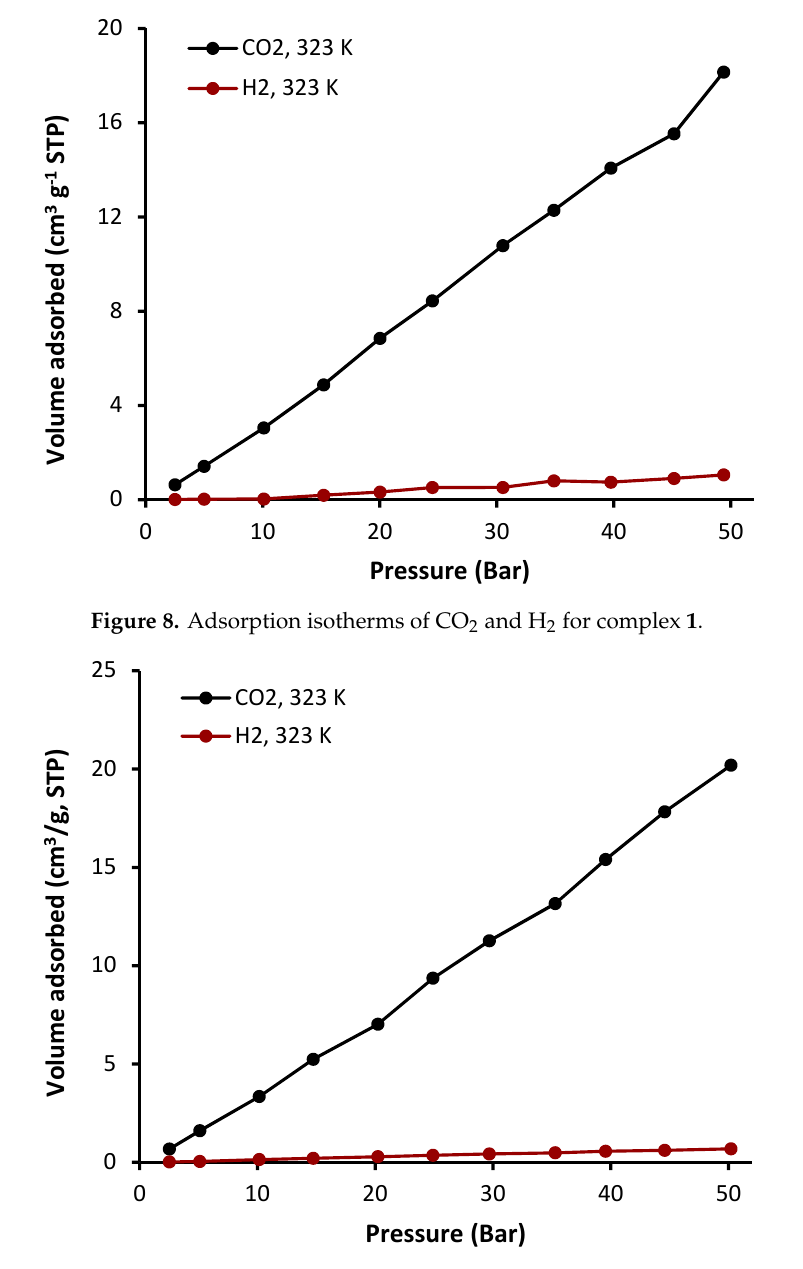
Figure 10. Adsorption isotherms of CO 2 and H 2 for complex 3 .